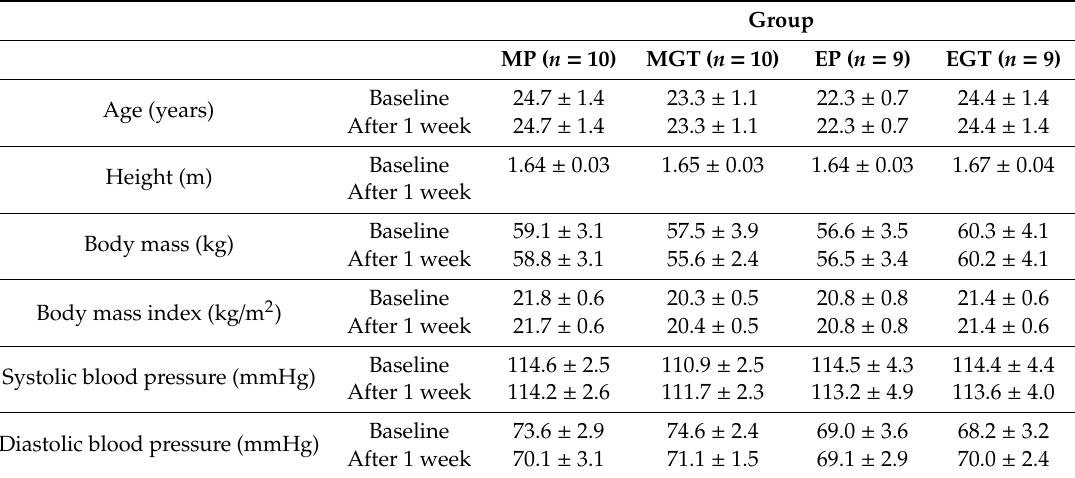
Table 2. Physical characteristics at baseline and after 1